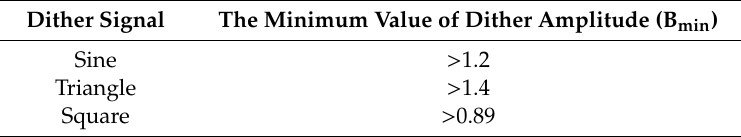
Table 2. The minimum value of dither